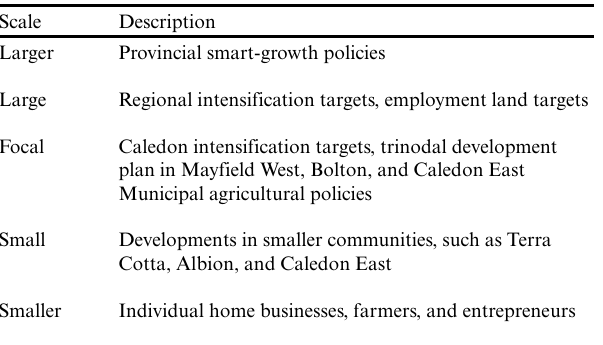
Table 4. Scales in the ecological domain of Caledon in the context of urban growth